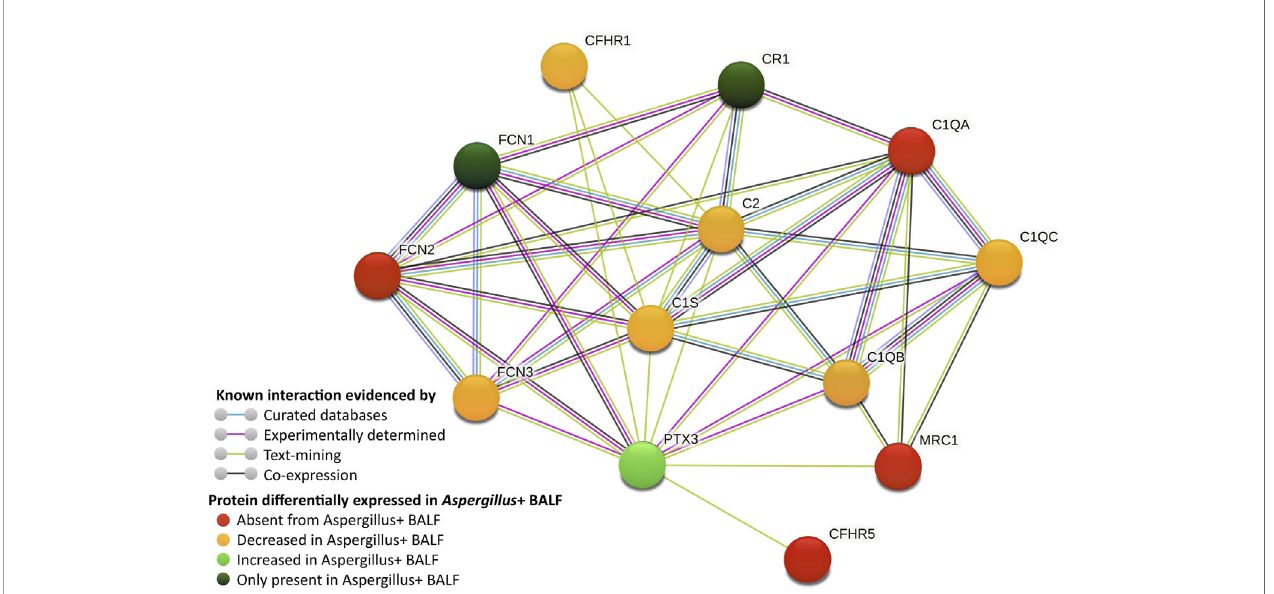
FIGURE 2 | Network of complement components interacting with pentraxin-3 (PTX3), which are differentially expressed in Aspergillus + BALF (generated using STRING database). CFHR, complement factor-H related protein; CR, complement receptor; FCN, fi colin; MRC, macrophage mannose receptor; C1, complement proteins 1; C2, complement protein